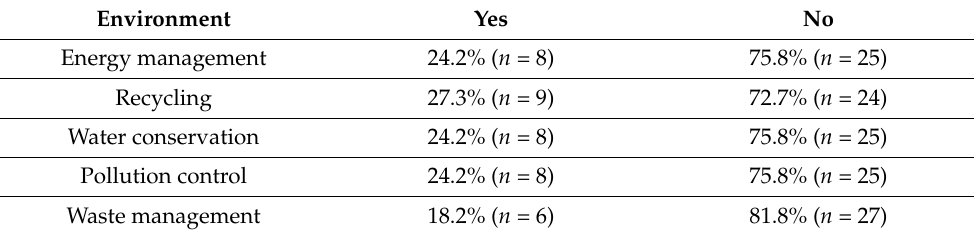
Table 6. Aspects of CSR activities: